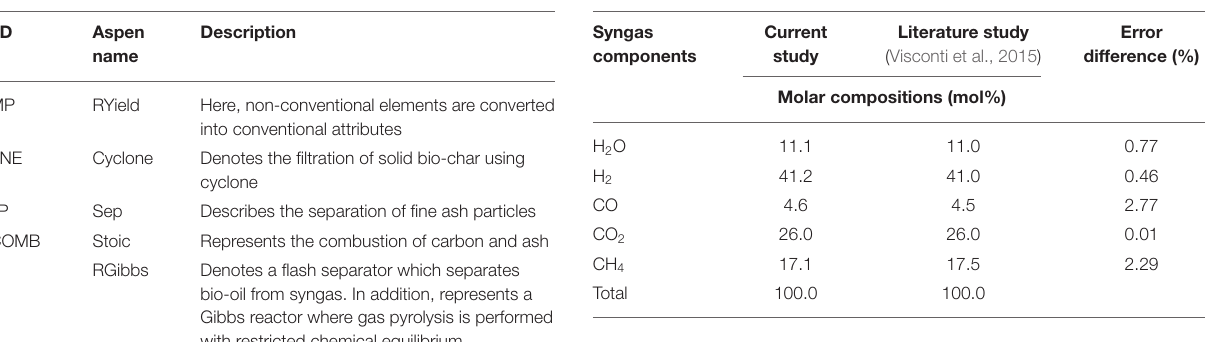
TABLE 3 | Description of each block used in the flowsheet. TABLE 4 | Model validation: Current study versus previous reported